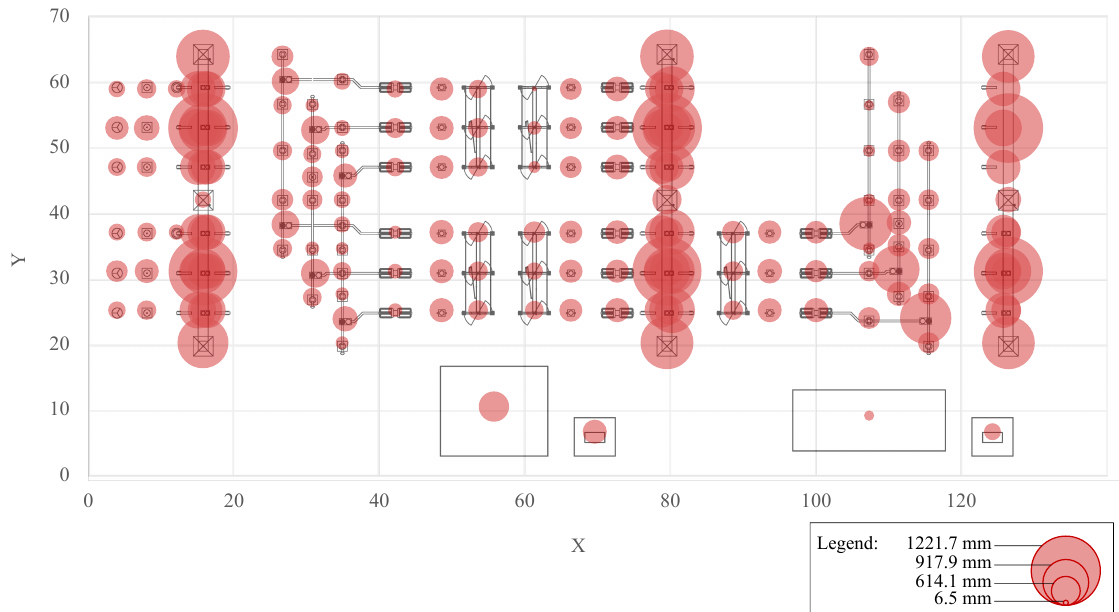
Figure 23. Manual positioning errors of equipment compared to the Authoring System methodology.